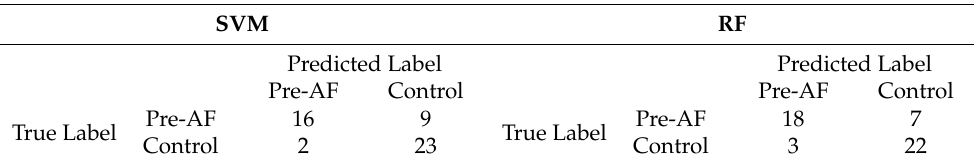
Table 8. Confusion matrix on the test data (10 min before onset).